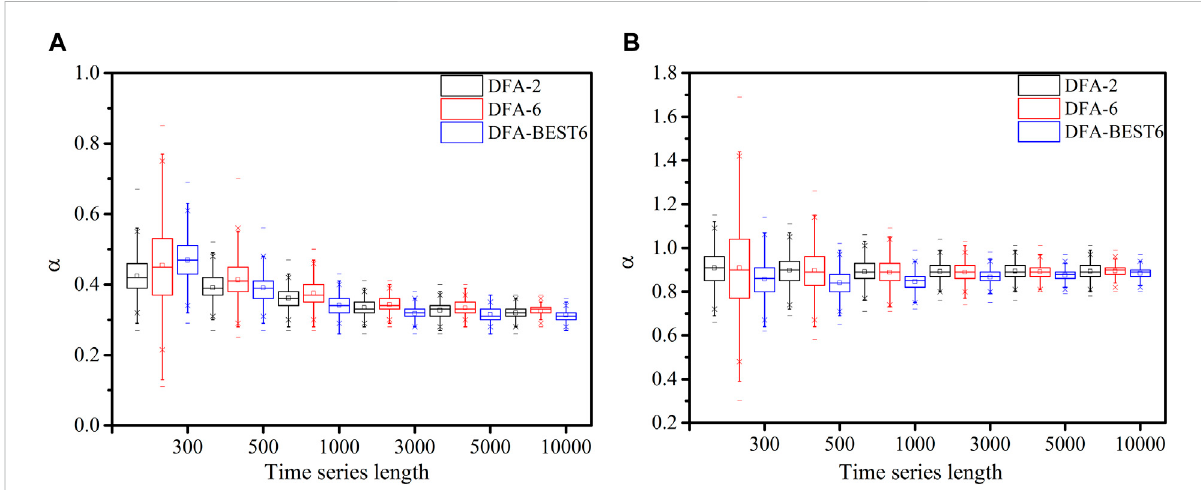
FIGURE 6 The box chart for results of DFA-2, DFA-6 and DFA-BEST6 tests for 2000 samples with data length varied from 300 to 10,000 and scaling exponents of (A) 0.3, (B) 0.9.